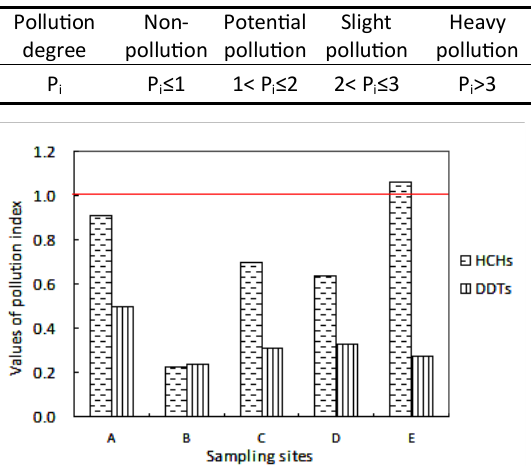
Fig. 4. Comparison of soil pollution index values of HCHs and DDTs in park soil from Ulaanbaatar